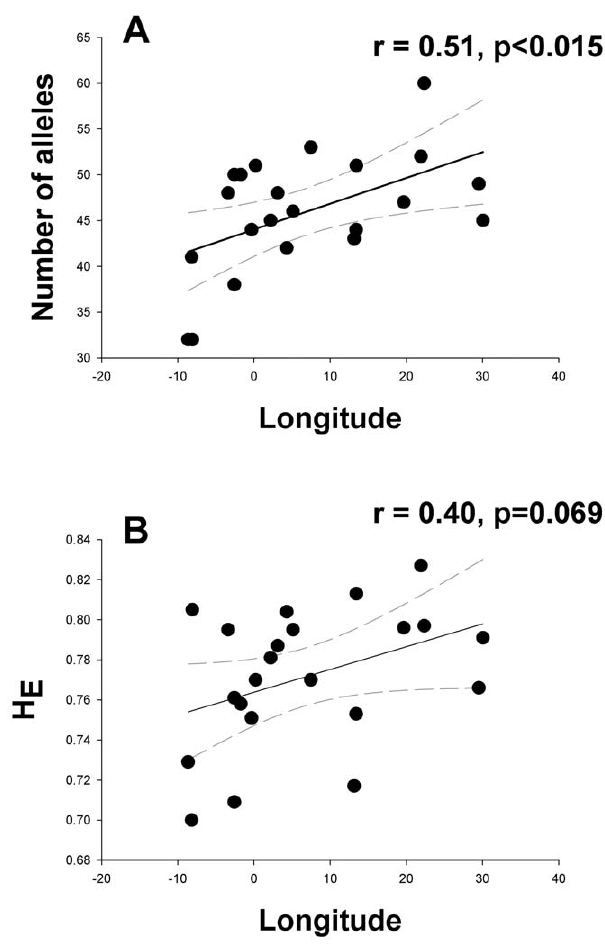
Figure 2. Linear regression between longitude and allelic richness of I.elegans populations (n=22, r=0.51, p , 0.0015).